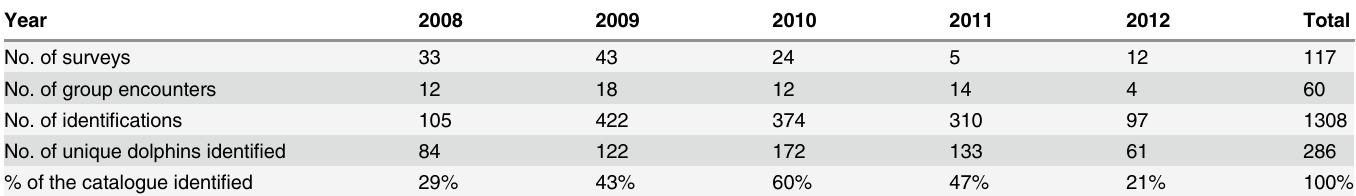
Table 1. Survey effort and photo identification analysis.